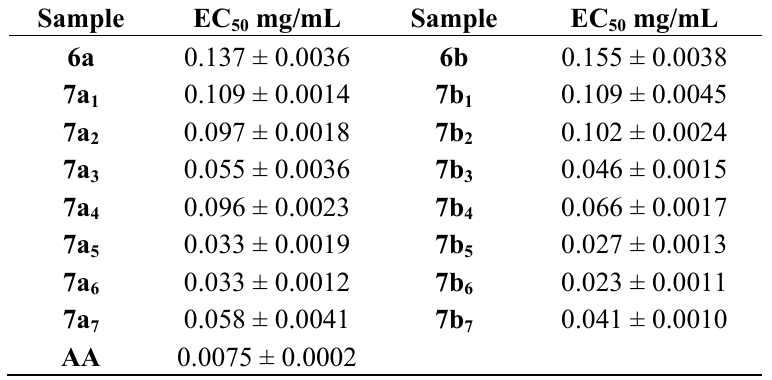
mg/mL) of the derivatives 6a , 6b , 7a 50